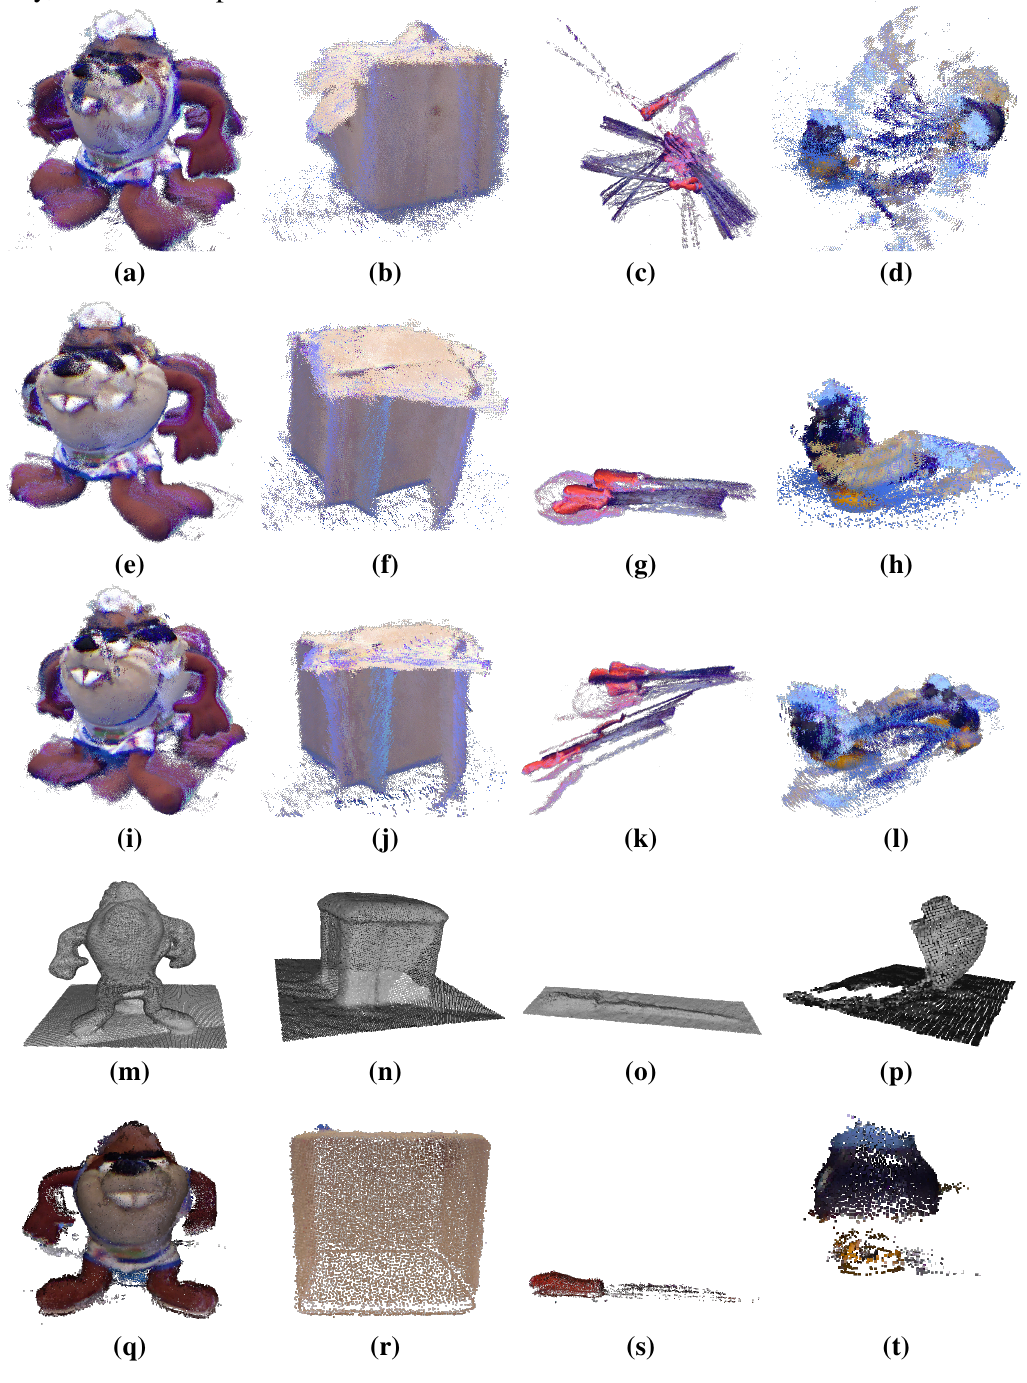
Figure 15. Object registration results of the tested methods. First row: RANSAC with SIFT features registration. Second row: ICP registration. The third row shows the result of the RANSAC and ICP combination. The fourth row presents the results of